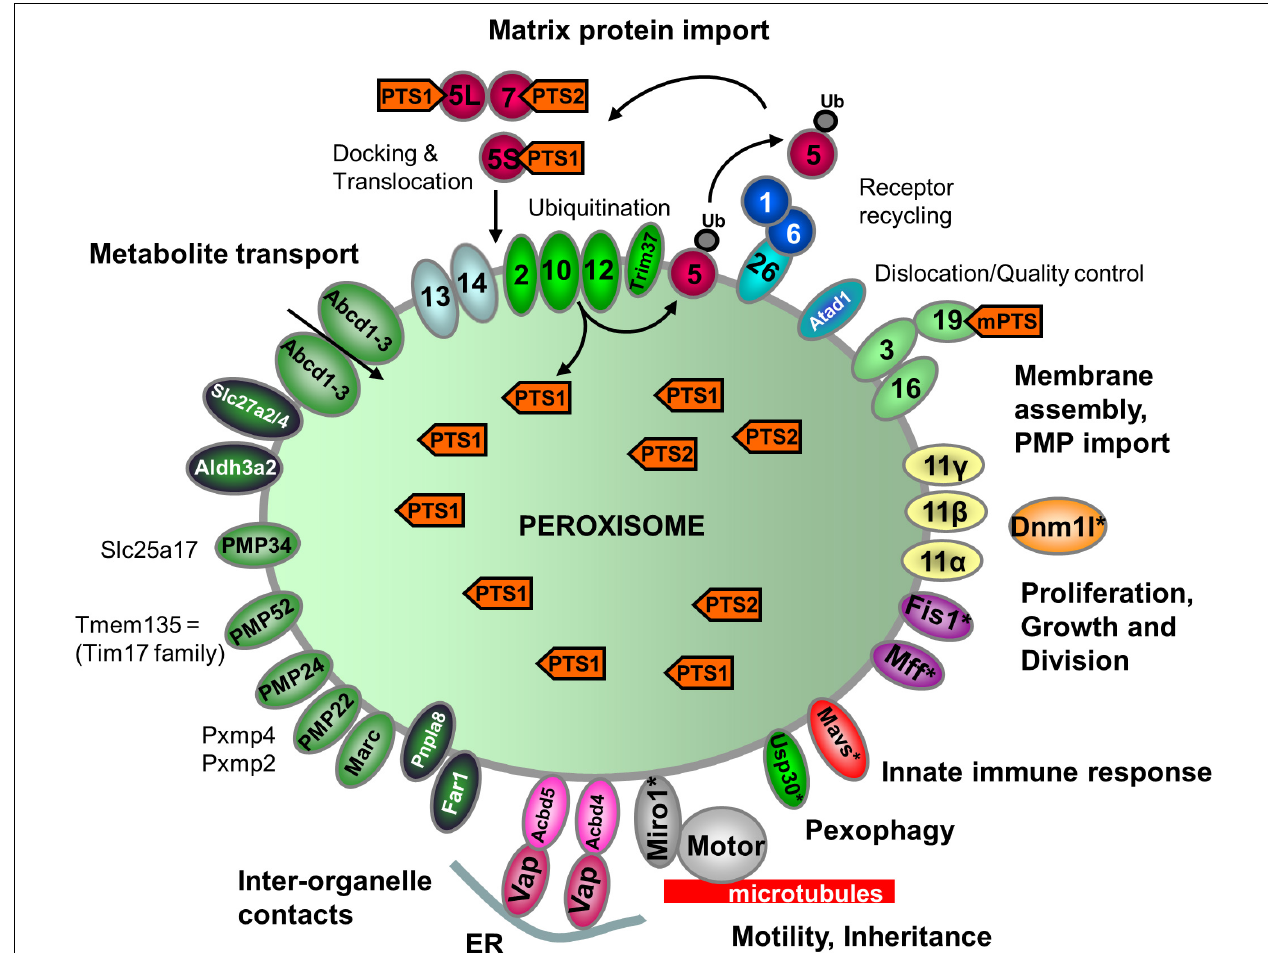
FIGURE 2 | Schematic overview of the predicted molecular machineries and D. rerio proteins localized at the membranes of peroxisomes in zebrafish. See text for further details. Matrix protein import : after synthesis on free ribosomes, cargo proteins containing the peroxisomal targeting signals PTS1 or PTS2 bind to the corresponding cytosolic receptors Pex5 (E7FGF7) or Pex7 (A8KBW8) (Pex-proteins are indicated as sole numbers) and form receptor–cargo complexes. The Pex7–cargo complex requires accessory factors for import (e.g., Pex5L, a long isoform of Pex5). Import is achieved by a complex set of integral or peripheral PMPs that form the matrix protein import machinery, which mediates docking of the cargo-bound import receptor at the peroxisomal membrane [Pex13 (Q6PFQ3), Pex14 (A0A2R8QMZ2)], cargo translocation into the matrix of the organelle by a dynamic translocon [Pex2 (E7F4V8), Pex10 (Q5XJ92), Pex12 (B0R157)], and export of the receptor back to the cytosol [Pex1 (A0A0R4IPF0), Pex6 (F1QMB0)]. Recycling of the receptor involves its ubiquitination (Ub) and extraction from the membrane by an AAA–ATPase complex (Pex1, Pex6). Pex6 binds to the membrane protein Pex26 (F1RBL0). Membrane assembly and insertion of PMPs (containing an mPTS) depend on Pex19 (F1R313), Pex3 (Q5RIV3), and Pex16 (F1RDG2). Pex19 functions as a cycling receptor/chaperone, which binds the PMPs in the cytosol and interacts with Pex3 at the peroxisomal membrane. Proliferation, growth and division : Pex11 α (A3QJY9), Pex11 β (Q0P453), and Pex11 γ (Q4V8Z0) are involved in the regulation of peroxisome size and number (proliferation). Pex11 β remodels the peroxisomal membrane and interacts with the membrane adaptors Mff (F1Q877; A8E7S0) and Fis1 (A0A2R8Q8G0), which recruit the dynamin 1-like fission GTPase Dnm1l to peroxisomes, which in mammals is activated by Pex11 β . Motility : mammalian peroxisomes move along microtubules, and Miro/Rhot (Rhot1a, Q6NVC5; Rhot1b, A0A0R4IGX0; Rhot2, Q32LU1) serves as membrane adaptor for the microtubule-dependent motor proteins kinesin and dynein. Tethering : Acbd5 (E9QCH6; A5WV69) and Acbd4 (F1QA31) interact with ER-resident Vap (Vapb, Q6P2B0) to mediate peroxisome–ER contacts. Metabolite transport : uptake of fatty acids in D. rerio peroxisomes is mediated by ABC transporter proteins (Abcd1, F1RBC8; Abcd2, E7F973; Abcd3a, A0A0R4IRL4; Abcd3b, B0UY91). Other peroxisomal transporter and membrane proteins in zebrafish include (functions are in part unclear): PMP34 (Slc25a17) (A5D6T2), a peroxisomal CoA transporter; PMP52 (Tmem135) (A4QN71) and PMP24 (Pxmp4) (A0A2R8QFW3) belong to the Tim17 family of transporters; PMP22 (Pxmp2) (Q66HU7); Slc27a2/4 (F1QQC5, Q1ECW0; Q567D7), acyl-CoA synthetase long chain family member; Marc (A0A2R8PWS6), mitochondrial amidoxime reducing component; Atad1 (A0A2R8RM20, B2GP29), ATPase family AAA (ATPase associated with various cellular activities) domain-containing protein 1 with a potential role in dislocation/quality control of tail-anchored membrane proteins; Aldh3a2 (A0A2R8PW97, E9QH31), fatty aldehyde dehydrogenase; Far1/2 (A0A0R4ICF6/Q1L8Q4), fatty acyl-CoA reductase 1/2 (ether lipid biosynthesis); Mavs (F1REK4), mitochondrial antiviral signalling protein with a putative role in innate immune response; Trim37 (E7FBZ8), tripartite motif-containing protein 37, an E3 ubiquitin-protein ligase involved in Pex5 mediated peroxisomal matrix protein import; Usp30 (A2BGT0), ubiquitin-specific protease 30, a deubiquitinase involved in the turnover of peroxisomes; Pnpla8 (F1RE62), Patatin-like phospholipase domain-containing 8. Proteins with a potential dual localization to both peroxisomes and mitochondria are marked with an asterisk. Pex, peroxin; PMP, peroxisomal membrane protein (adapted from Islinger et al., 2018, but containing the zebrafish specific nomenclature).